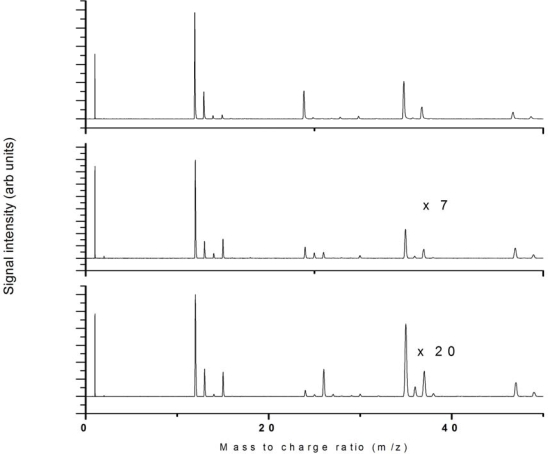
Comparison of nonresonant nanosecond laser ionization using: (a) 266 nm, 9 × 1011 W/cm2, (b) 355 nm, 6.8 × 1011 W/cm2, (c) 532 nm, 2.8 × 1012 W/cm2.